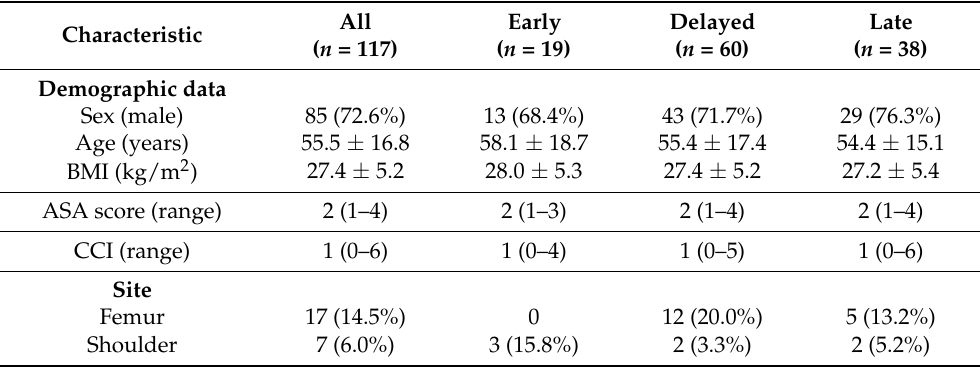
Table 1. Baseline characteristics of the FRI